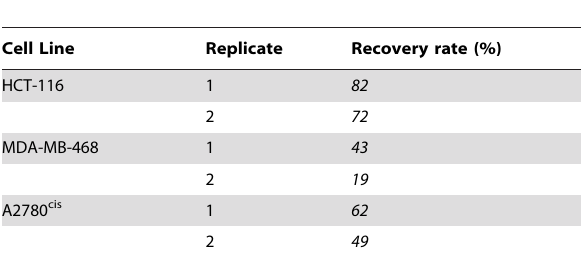
Table 4. Barcode recovery rate in Athymic Nude xenograft